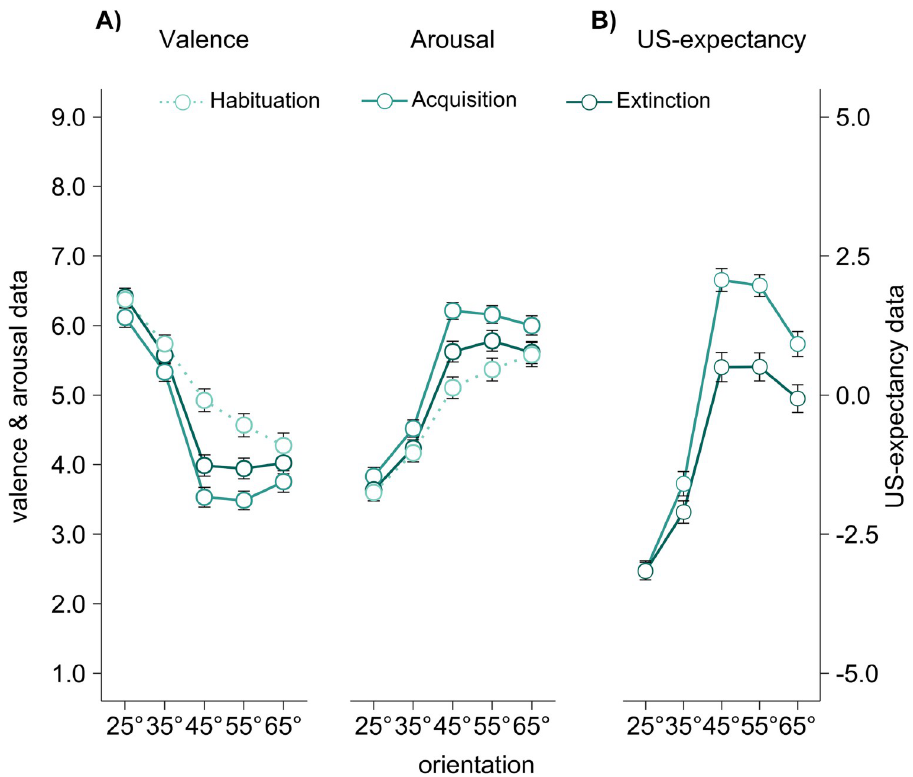
Fig 3. Validation of fear acquisition and extinction. Validation of fear acquisition and extinction for valence and arousal ratings (A) and US-expectancy ratings (B) . Valence of each CS grating was rated via Self-Assessment Manikins (SAM) on a 9-point scale from 1 (unpleasant) to 9 (pleasant). Similarly, arousal ratings were conducted via SAMs, here ranging from 1 (calm) to 9 (arousing) (see also Materials and Methods section [Dependent variables]) . US expectancies after acquisition and extinction were rated on a scale from -5 (very certain, no US after this CS) over 0 (uncertain) to 5 (very certain, a US will follow this CS). Each data point represents averaged valence, arousal, or US-expectancy ratings, separately for acquisition and extinction but not differentiated for synchronization and frequency. Error bars show ± 1